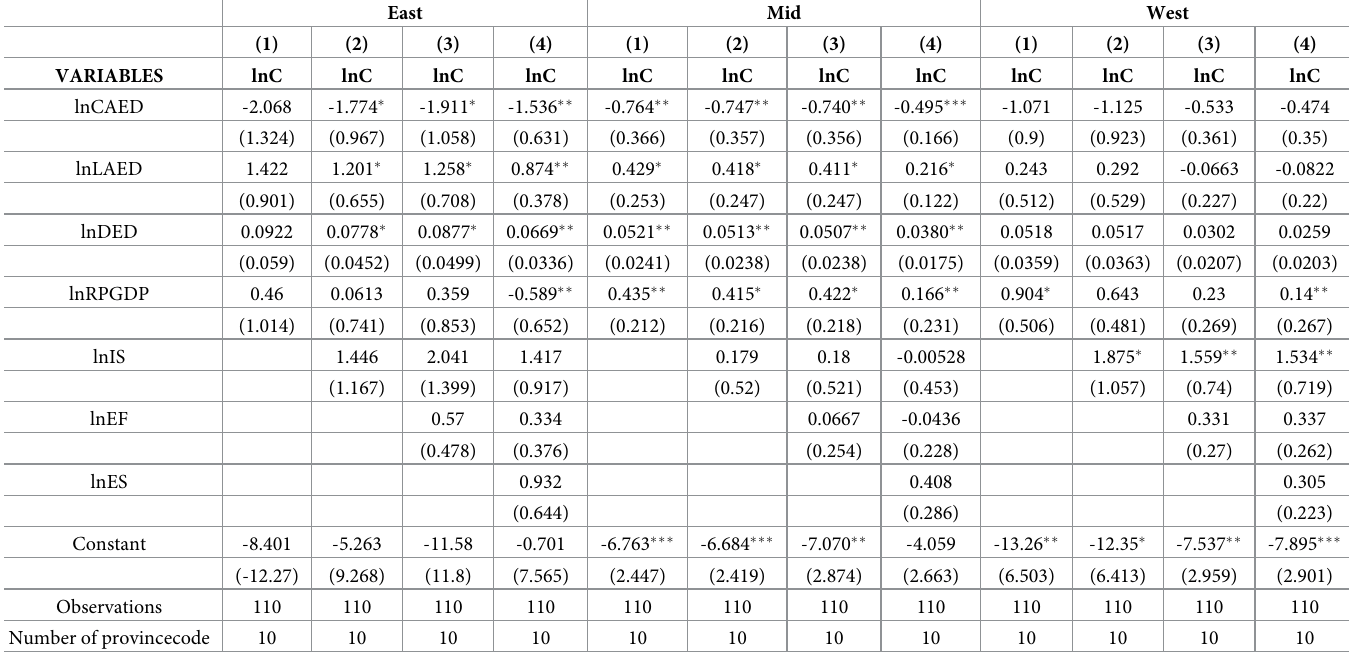
Table 5. Regression results of the